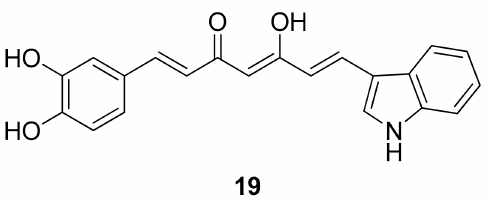
Figure 8. Structure of compound 19 with an indole aromatic